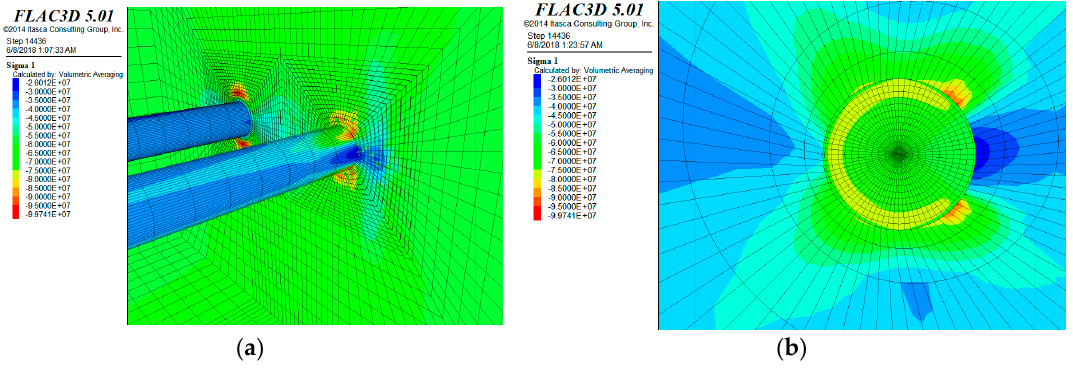
Figure 11. Contours of maximum principal stress: ( a ) in twin tunnels and ( b ) on the face of right tunnel.